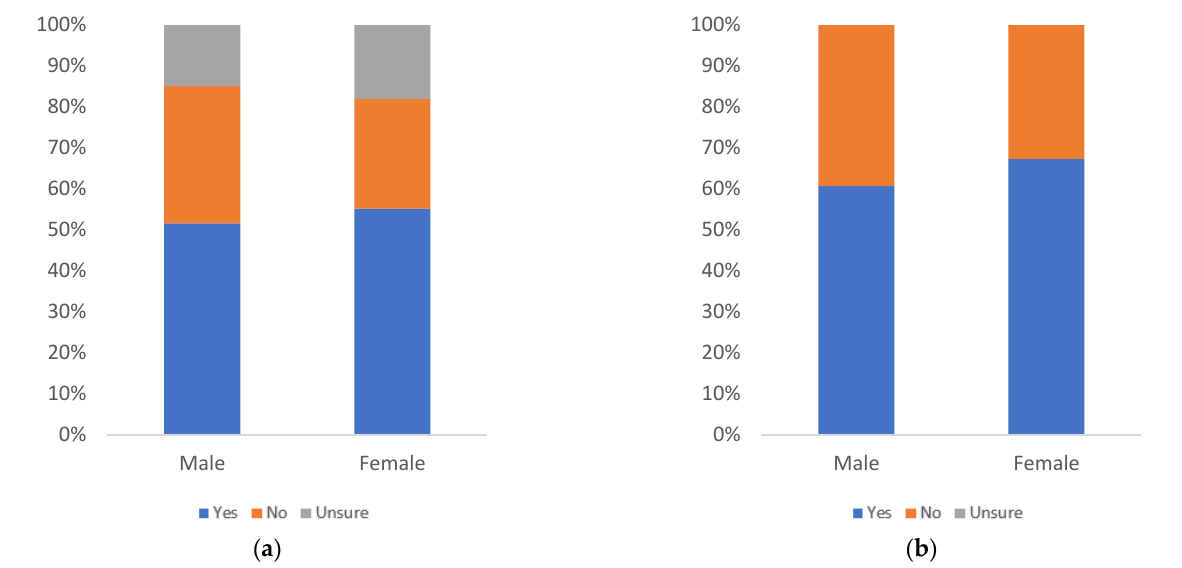
Figure 13. Label use, by gender: ( a ) with uncertain respondents (left) and ( b ) without uncertain respondents (right).